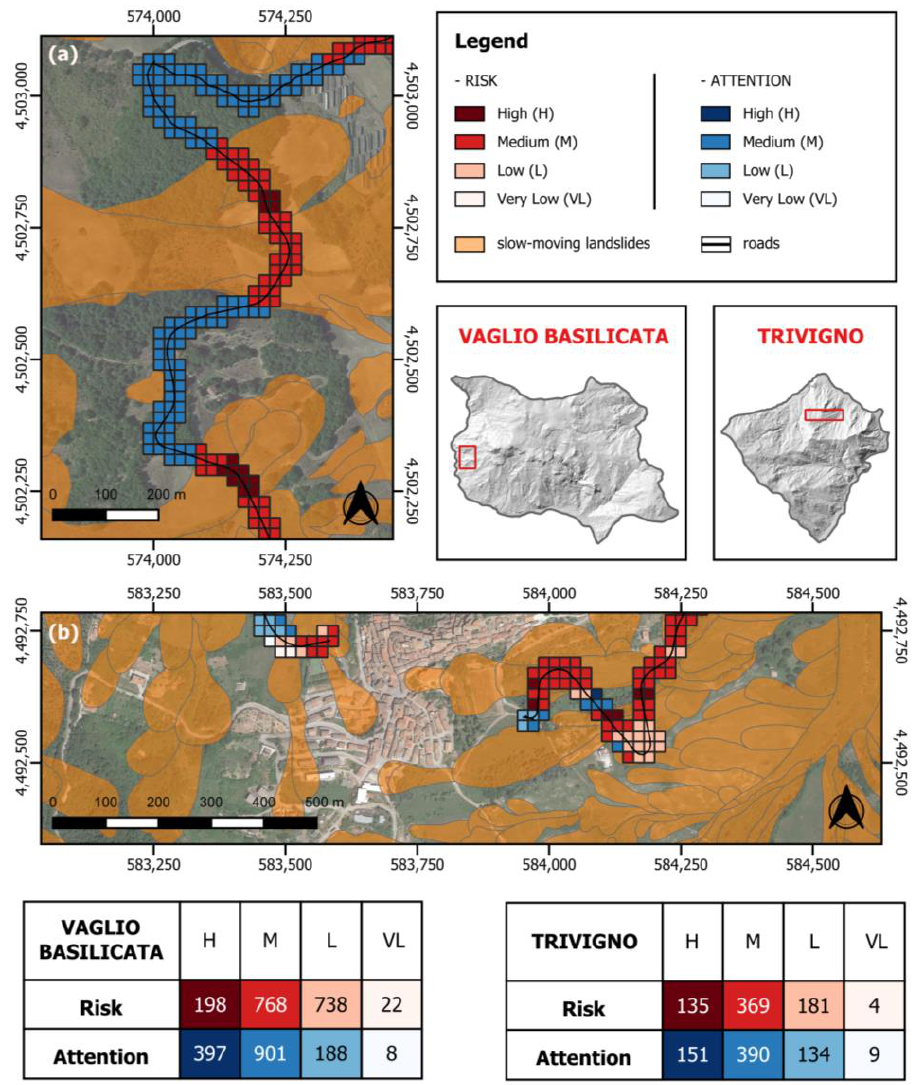
Figure 7. Excerpts of maps produced by the procedure in two small portions of the study area in Vaglio Basilicata ( a ) and Trivigno ( b ). The tables below report the correlation matrices obtained for the classification carried out over the entire territory of the two study